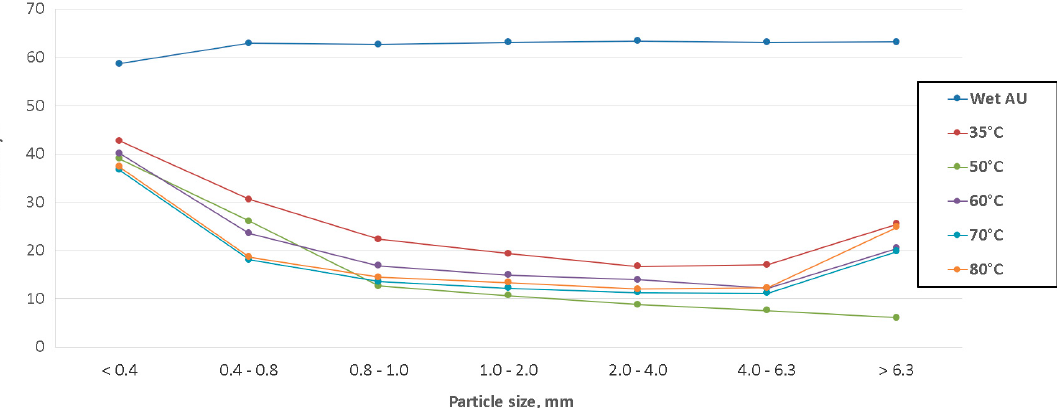
Figure 7. Difference between the moisture content of particles of different sizes for wet and dried lignite—an example of Australian lignite for various temperatures of the drying process. Drying kinetics, for Sieniawa lignite, in the torbed installation and total energy consumption per kg of removed water are presented in Figures 9 and 10, respectively. Figure 9 shows curves representing the loss of moisture for the lignite from Sieniawa mine. Below the final moisture content of 15% a significant reduction in drying rate occurs for all temperatures of the drying agent. This value is called critical moisture content and depends mostly on the structure of the lignite and its chemistry. This is a useful indicator that allows to determine the proportion of the water held physically within the structure of the lignite through capillary forces and the amount of water bound chemically, for example by weak hydrogen bonds with OH functional groups. The parameter itself does not give a sharp cut away point and depends slightly on the drying